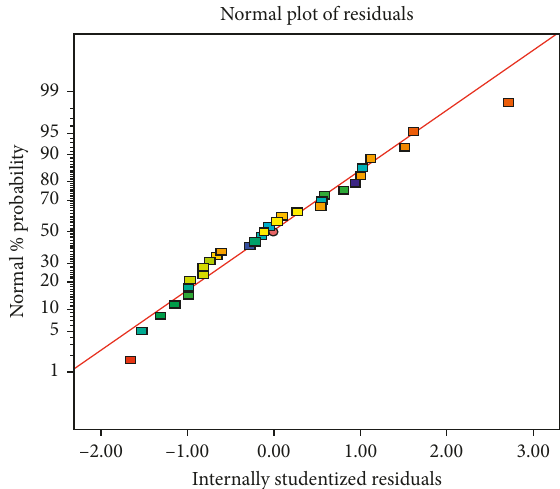
Figure 1: Correlation of calculated hordein with experimentally extracted hordein.